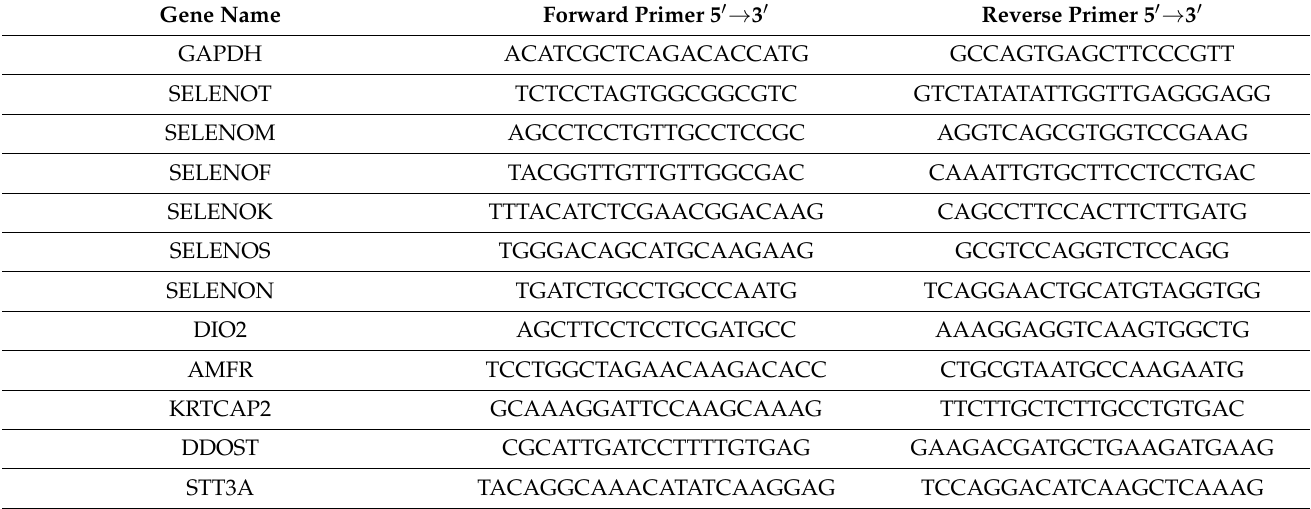
Table 1. Primers for real-time